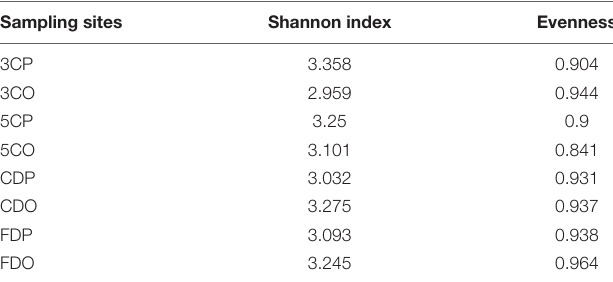
TABLE 4 | Shannon index in different sampling sites over the 1